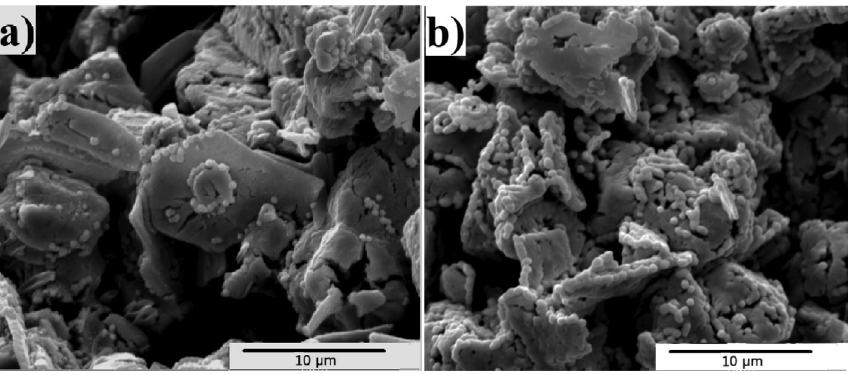
Fig. 5: Morphologies of Mo by reducing MoO 2 powders in dry hydrogen at (a) 1223 K and (b) 1273 K (SEM ×10000).